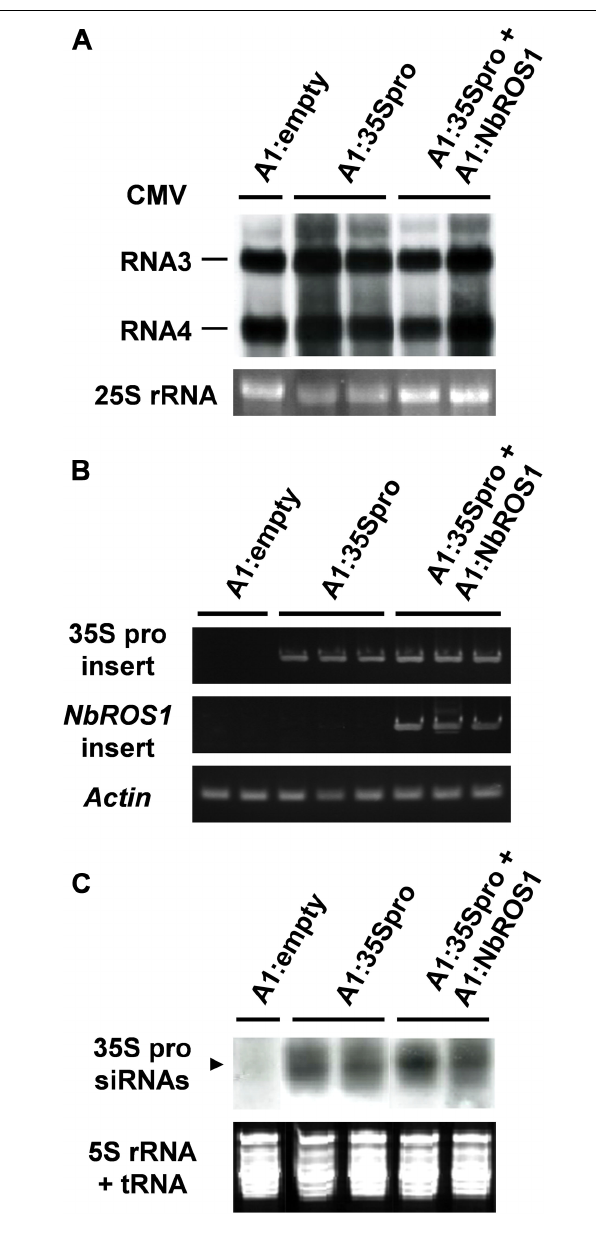
FIGURE 5 |Analysis of viral RNAs in plants infected with recombinant CMVs. (A) Northern blot analysis of viral RNAs using a CMV RNA-specific probe. Hybridization signals of CMV RNAs 3 and 4 are shown. Ethidium-bromide-stained 25S RNA bands are shown below the panel to show that an equal amount of RNA was loaded. (B) RT-PCR analysis of viral RNAs. RT-PCR was done using a combination of primers: a primer that anneals a region adjacent to the cloning site of the viral vector and a primer that anneals the CaMV 35S promoter or NbROS1 fragment inserted in the vector. A portion of the actin gene was amplified as a control. (C) Production of siRNAs corresponding to the CaMV 35S promoter in plants infected with recombinant CMVs. Northern blot analysis was done using low-molecular weight RNAs isolated from leaf tissues of the plants infected with the recombinant CMVs at 18 DPI, probed for the CaMV 35S promoter. Ethidium-bromide-stained 5S rRNA and tRNAs bands are shown below the panel to show that an equal amount of the small RNA fraction was loaded. In (A–C) , data obtained from two or three individual plants infected with recombinant CMVs are shown.